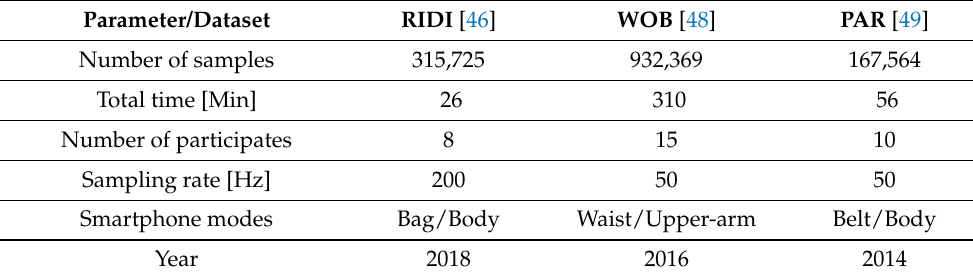
Table 3. Main parameters of the three datasets used in the testing process.